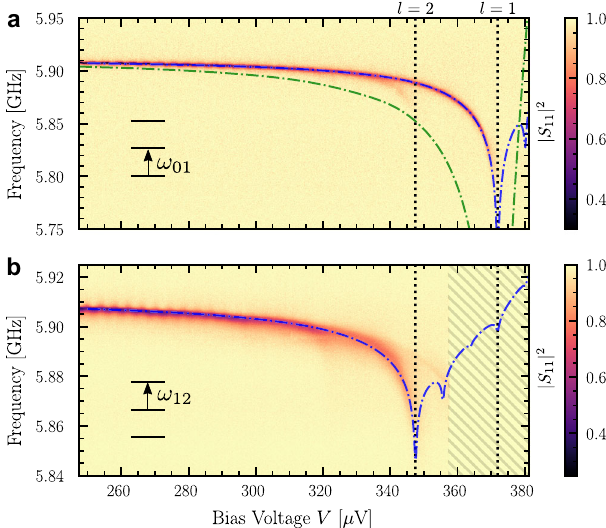
Fig. 4 | One and two-photon spectroscopy as a function of voltage. a Re fl ected signalmeasuredwithaninjectedmicrowavepowerof − 140dBm( η ≈ 2 π ×2MHz)as a function of frequency and bias voltage. The power is suf fi ciently low to mostly probe the 0 → 1 transition. The vertical lines are the same as in Fig. 1. b Re fl ected signal in the presence of a second microwave tone tuned at the frequency mea- sured in a . This two-photon spectroscopy probes the 1 → 2 transition, which shifts differentlythanthe0 → 1transition,showingthenon-linearityinducedbytheLamb shift. In both cases, the dashed blue lines correspond to the prediction of an ab initio quantum model. The dashed green line in a corresponds to the classical approximation, keeping only terms of order λ 2 in the expression of the frequency shift. The hatched area was not